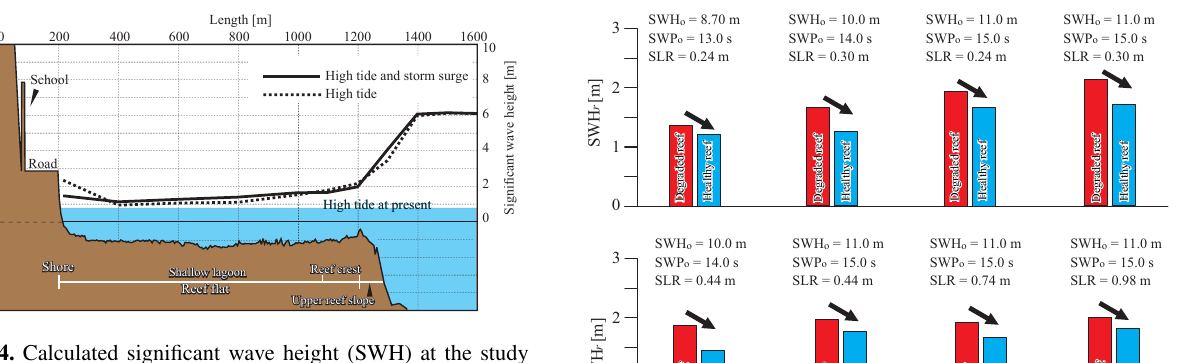
Figure 4. Calculated significant wave height (SWH) at the study site under high tide and storm surge (solid line) and high tide (dot- ted line). The assumed SWH o and SWP o values were 8.70m and 13.0s, respectively, for the present conditions model TC (i.e., Ty- phoon Bopha). The assumed WL o was + 0.80m (i.e., high tide) and + 1.80m (i.e., high tide and storm surge) above the present mean sea level (m.s.l.). Rapid wave breaking occurs in the upper reef slope– reef crest zone, whereas the reef flat is characterized by relatively calm conditions. The SWH value at the shore increases as the water depth decreases.